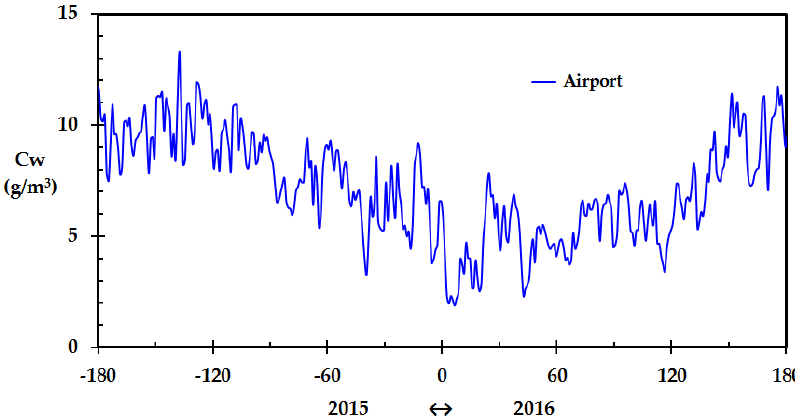
Figure 1. Calculated outdoor water concentration based on temperature and relative humidity recorded by the meteorological station (Haugesund airport), July 2015 through June 2016. (The x-axis represents days prior to and after New Year).